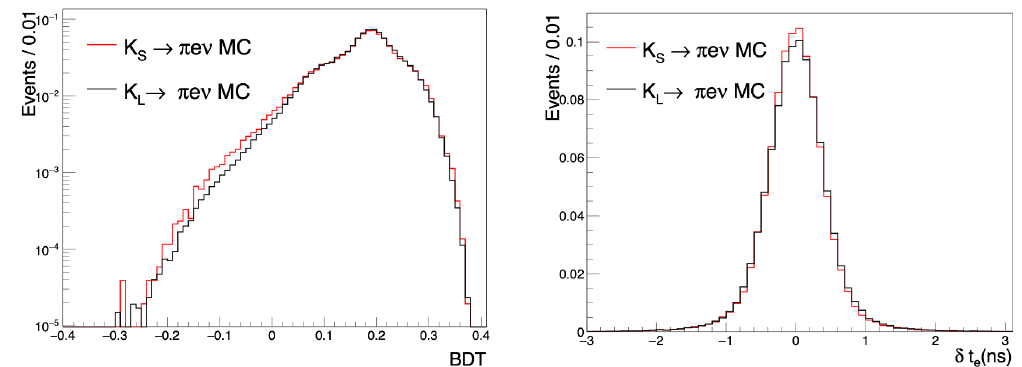
Figure 7 . Monte Carlo distributions of the BDT classifier output (left) and δt e (right) for K L → πeν (black) and K S → πeν (red) events.